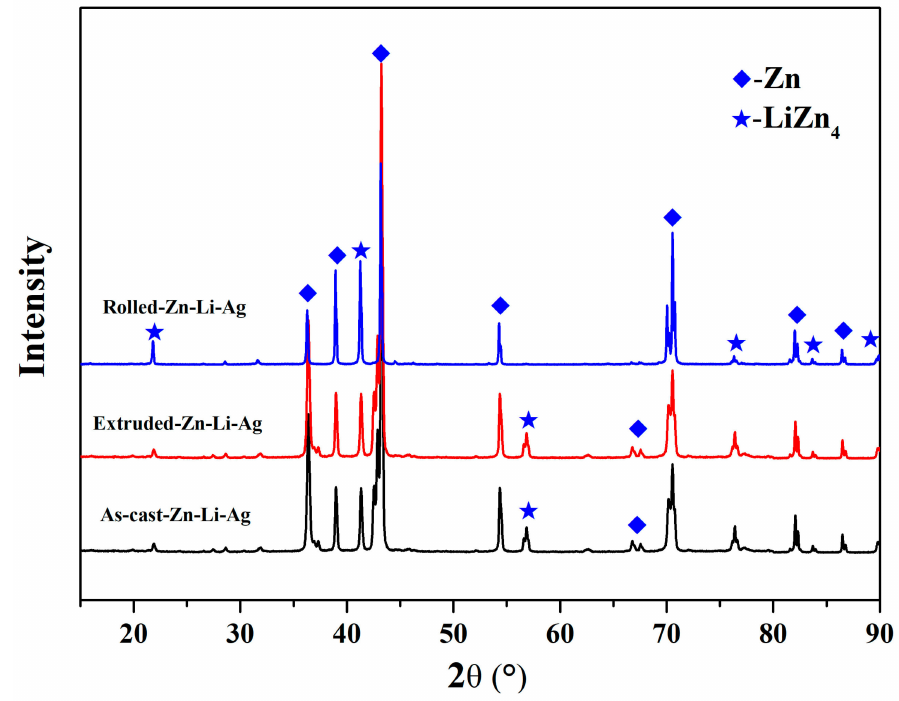
Figure 4. XRD analyses of the Zn-0.5%Li-0.1%Ag alloy in different treatment states.